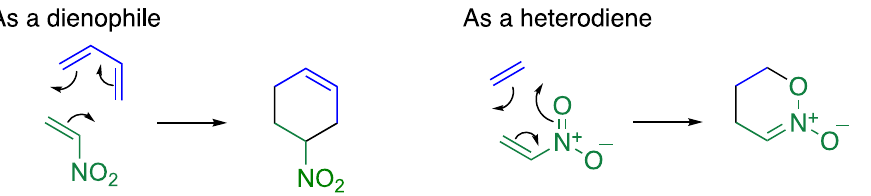
Figure 5. Dual behaviors of a nitroalkene in the cycloaddition reaction. Molecules 2020 , 25 , x 7 of 23